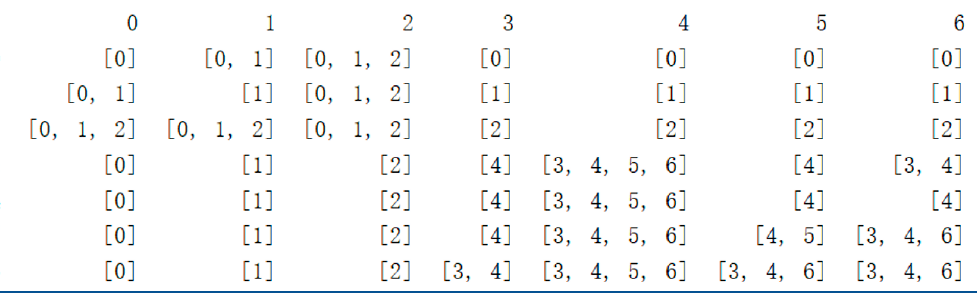
Figure 9. ( C , ▴ ) (running result of Python). Figure 9. ( C , (cid:78) ) (running result of